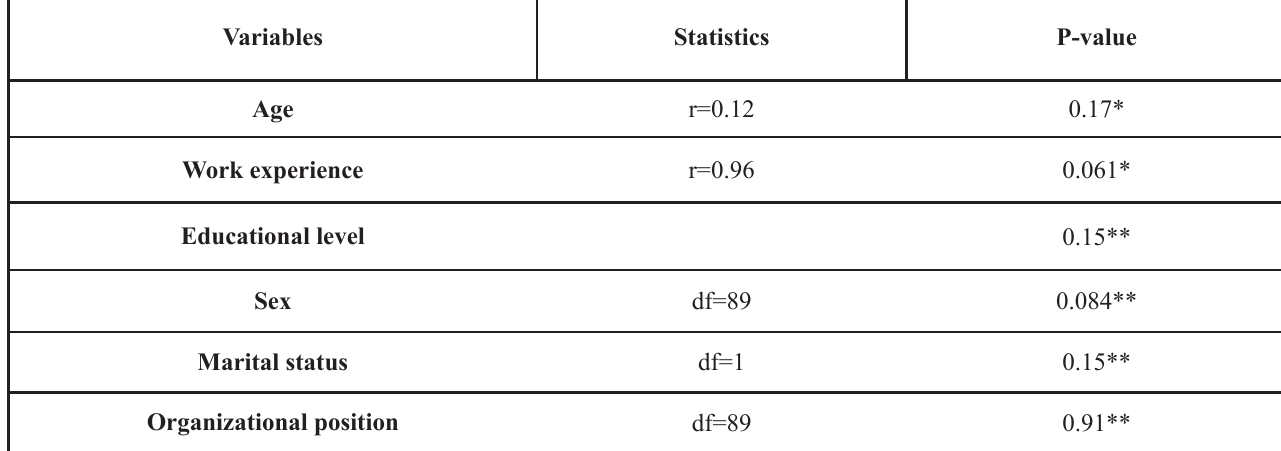
Table 5. Relationship between job satisfaction and some demographic characteristics of nurses